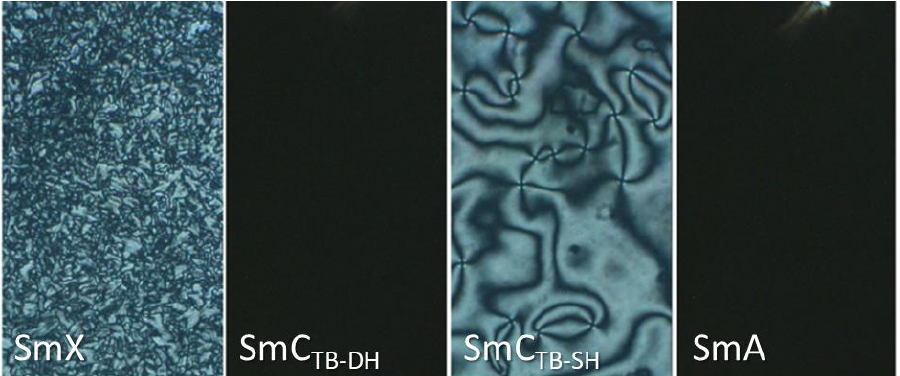
Figure 21. Optical textures of CB6O.14 observed between crossed polarizers in a 3 μm thick cell with homeotropic anchoring ( taken from [91]).